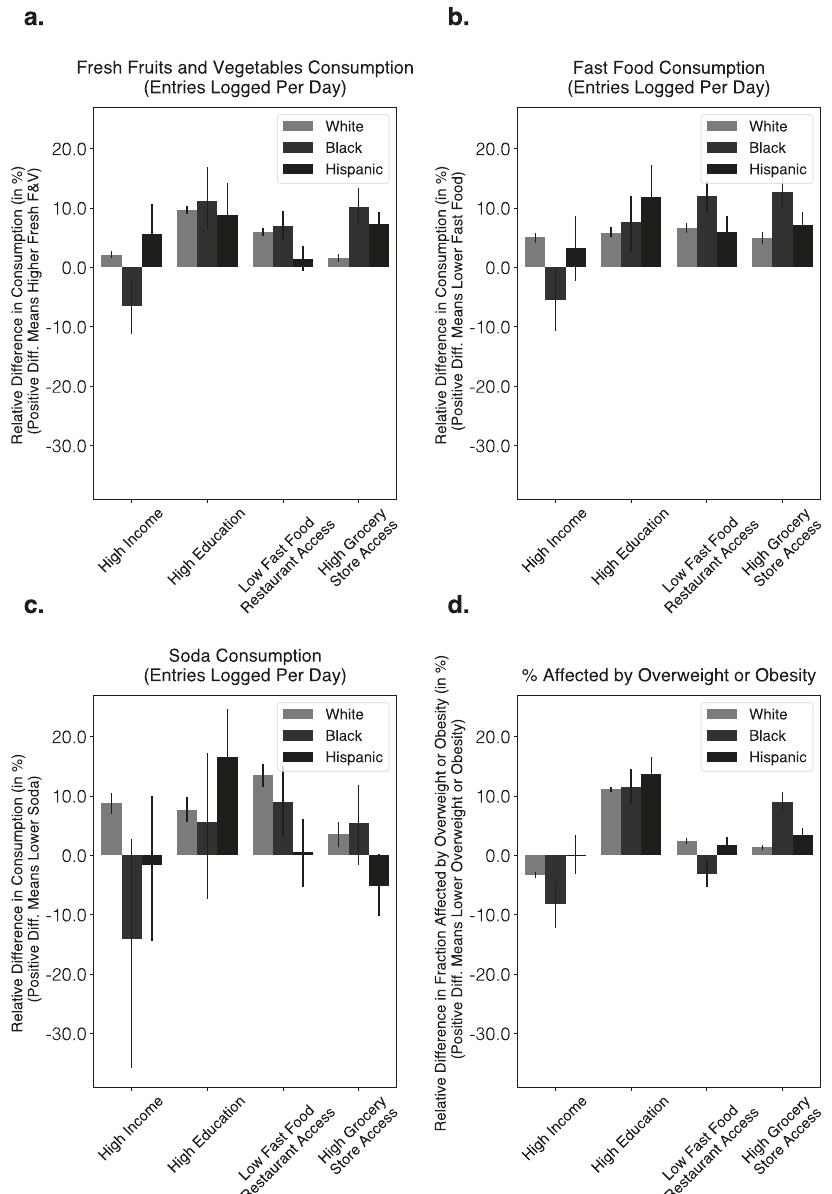
Fig. 5 Effect sizes for food consumption and BMI status disaggregated across zip codes with predominantly Black, Hispanic, and non-Hispanic white populations (i.e., 50% or more). Independent contributions of high income (median family income higher than or equal to $70,241), high educational attainment (fraction of population with college education 29.8% or higher), high grocery store access (fraction of population that is closer than 0.5 miles from nearest grocery store is greater than or equal to than 20.3%), and low fast food access (less than or equal to 5.0% of all businesses are fast-food chains) on relative difference in consumption of a fresh fruits and vegetables, b fast food, c soda, and d relative difference in fraction affected by overweight or obesity (BMI > 25). Cut points correspond to median values. Y -axes are oriented such that consistently higher is better. Estimates are based on matching experiments controlling for all but one treatment variable, across N = 4277, 4102, 3510, 3205 matched pairs of non-Hispanic white-majority zip codes, treated on income, educational attainment, fast food access, grocery store access respectively; N = 42, 74, 259, 259 matched pairs of Black- majority zip codes, treated on income, educational attainment, fast food access, grocery store access respectively; N = 67, 61, 297, 471 matched pairs of Hispanic-majority zip codes, treated on income, educational attainment, fast food access, grocery store access respectively (Methods). Bar height corresponds to mean values; error bars correspond to 95% bootstrap con fi dence intervals (Methods). We observe signi fi cant differences in outcomes between zip codes with predominantly Black, Hispanic, and non-Hispanic white